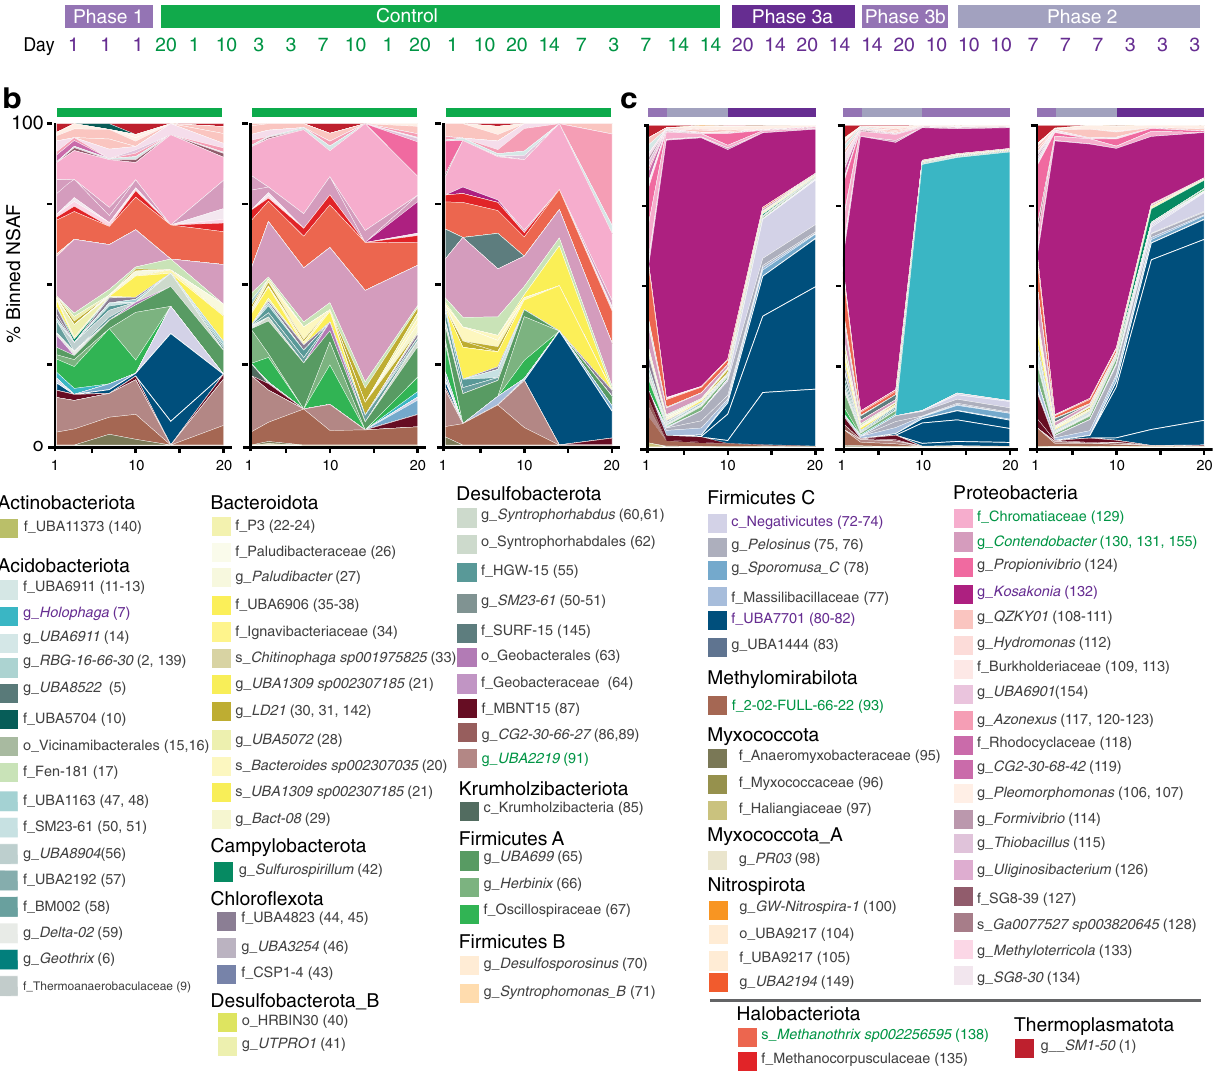
Fig. 5 Polyphenol-amended soil microbial communities showed distinct and dynamic metaproteome responses. a Hierarchical clustering of MAG- contributions (binned uniques) to metaproteome samples. Unamended control metaproteomes are shown in green, while the multi-phase response of CT- amended microcosms are highlighted with varying shades of purple. b , c Genome-resolved metaproteomic dynamics in CT-amended microcosms. The relative contribution of MAGs to the binned unique peptide pool is shown for the three unamended b control and c CT microcosm replicates over 20-days. The most re fi ned GTDB-tk assigned taxonomy is listed by phylum, with our MAG ID number in parentheses (Supplementary Data 2). The names of the top 5 peptide-recruiting MAGs are colored for CT (purple) and control (green) microcosms. Supplementary Fig. 11 shows this data with the total metaproteome data, including unbinned uniques, binned uniques, and